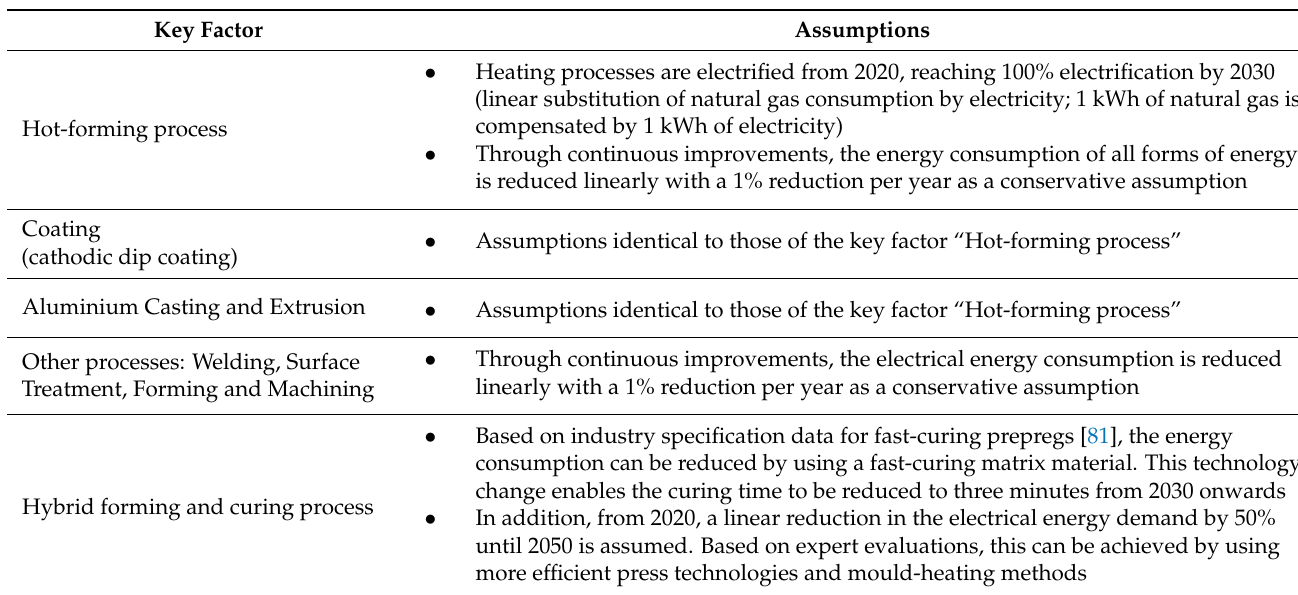
Table A1. Assumptions for the scenario development of the foreground